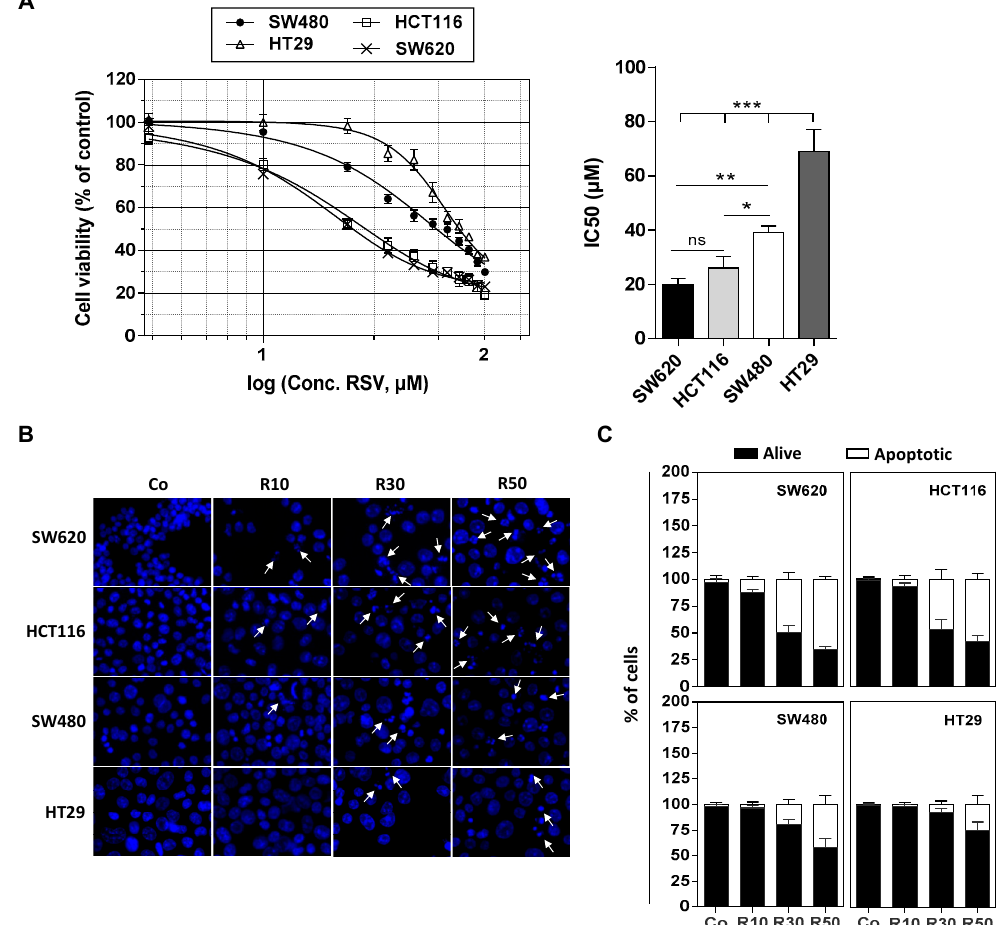
Figure 1. Differential sensitivity of human colorectal cancer cell lines to resveratrol. ( A ) After 24 h of culture, colon cancer cell lines SW480 and their metastatic phenotype SW620, HCT116, and HT29 were left untreated (Co, 0.1% ethanol) or were treated with increasing concentrations of resveratrol (RSV; concentrations ranging from 1 to 100 µM) for 72 h. Cell survival was expressed as a percentage of control cells (vehicle alone) after crystal violet staining. RSV concentrations were log 10 transformed and inhibitory concentrations 50% (IC 50 ) were determined after non-linear regression curve fitting and then plotted using GrapPad Prism software (left panel) . Data are mean ± S.D. of three independent experiments each containing six replicates per concentration (right panel). P - values were determined by one-way ANOVA followed by a Holm–Sidak post-hoc test. * p < 0.05, ** p < 0.01, and *** p < 0.001. ( B ) Cells were left untreated (Co) or treated with RSV at 10, 30, or 50 µM for 72 h before nuclear staining with Hoechst 33342. Representative fluorescence microscopy images of three independent experiments are shown, with white arrows indicating typical condensed/fragmented apoptotic nuclei. Original magnification: ×40. ( C ) Quantification of both alive and apoptotic cells was performed by counting intact and fragmented nuclei in 300 cells per cell line (randomly selected fields) with Image J software. Data were expressed as mean percentage ± S.D.